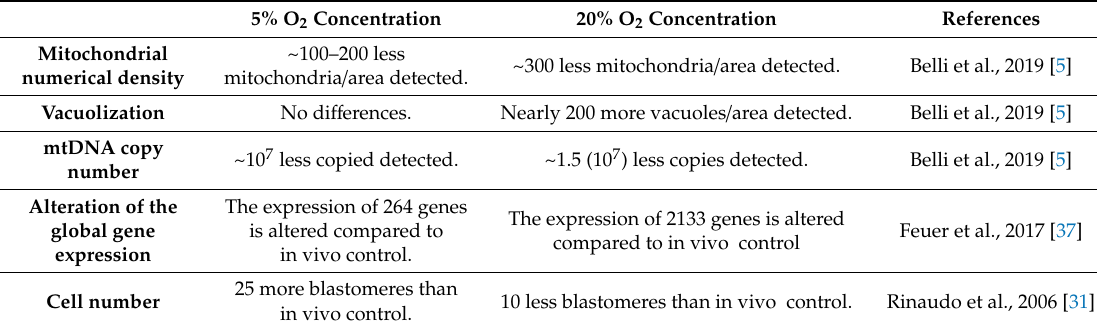
Table 3. Main alterations detected in prior studies of blastocysts cultured under physiologic (5%) and atmospheric (20%) O 2 concentration, compared to in vivo blastocysts. The relative increase is based assuming 100% in vivo